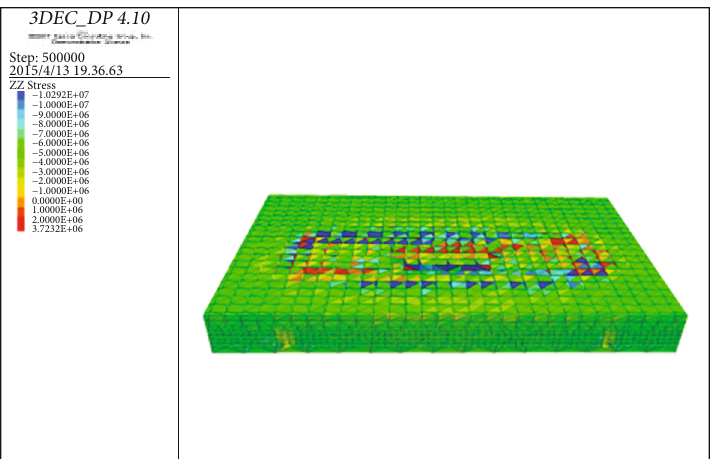
Figure 8: 600 m deep surrounding rock displacement diagram.